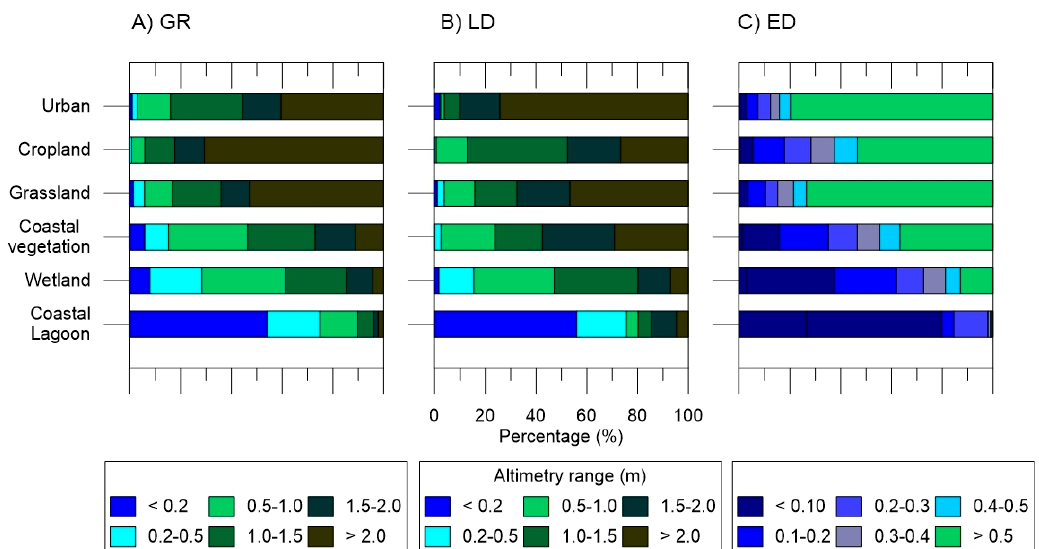
Figure 4. Vertical distribution of main habitat types in each study area. Values are the percentage (%) of a given habitat in a given altimetry range as a proportion of the total habitat surface within the study area. Note that the altimetry interval classes are different for each study area.